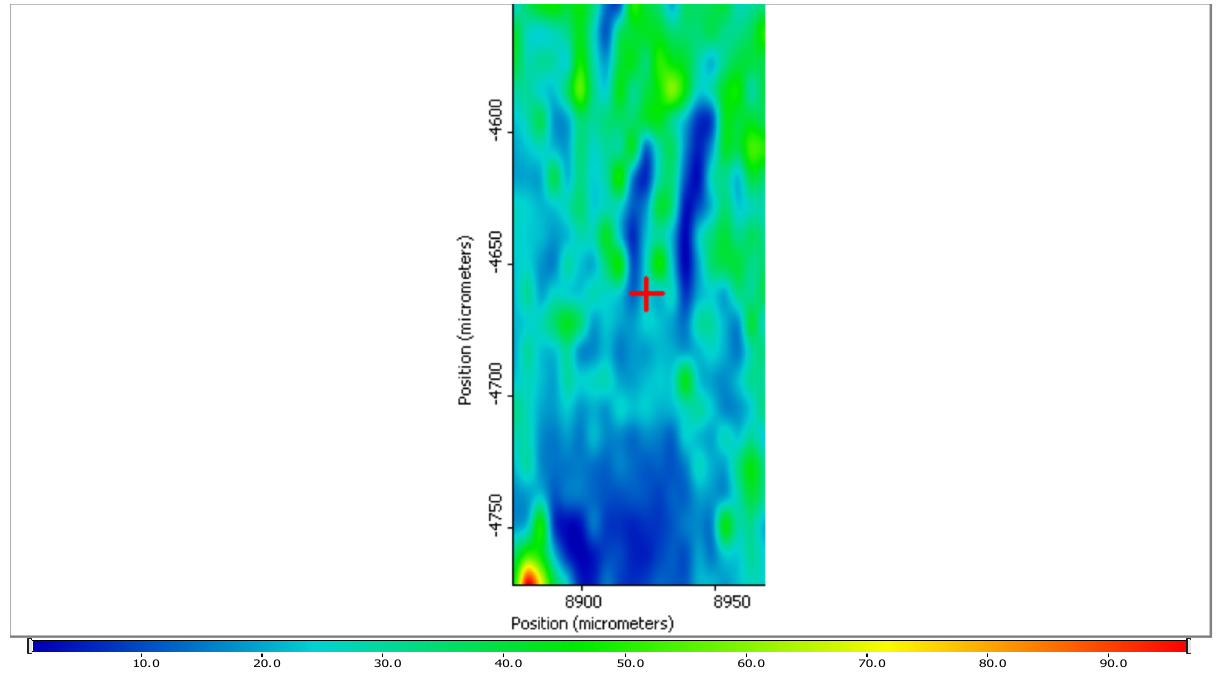
Figure 4. 1606 cm − 1 line Raman map, ZnO (pH9)/15 nm Cr/450 nm Ag nominal thickness (87GLAD).